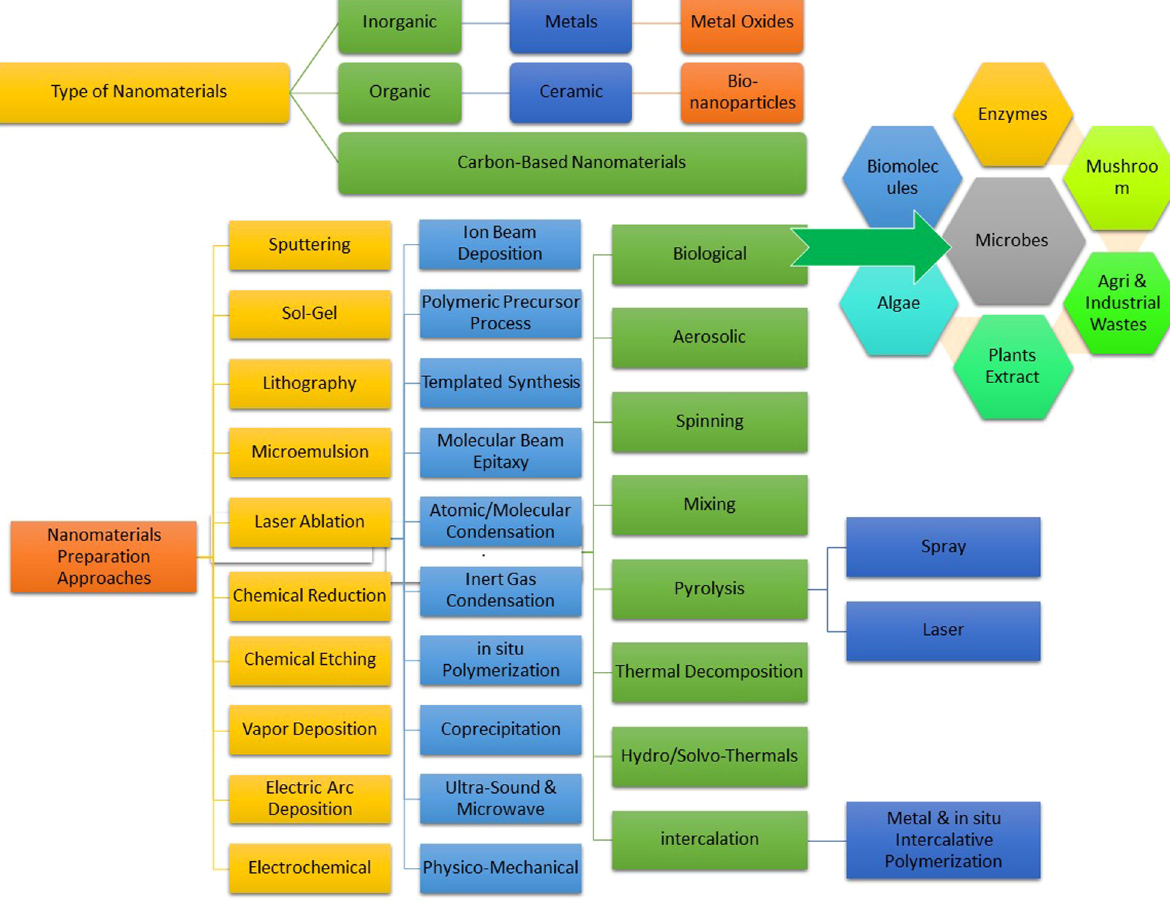
Figure 1: Various types of NP preparation